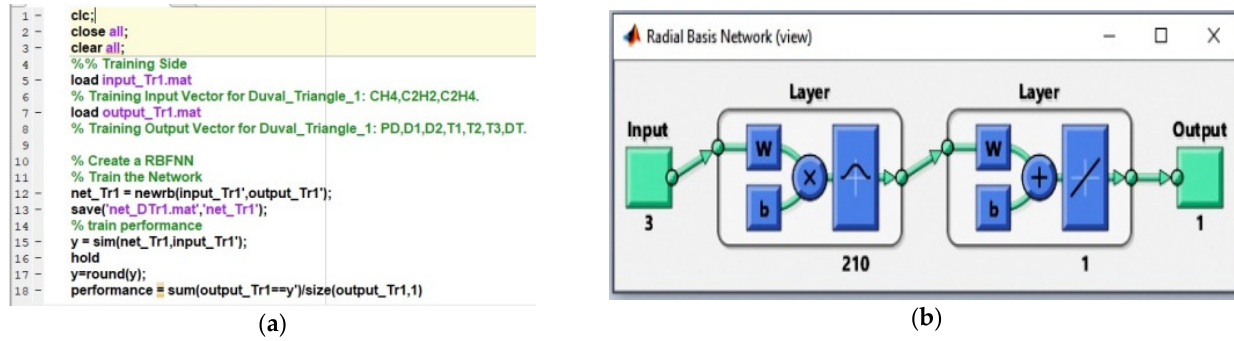
Figure 6. Example of the implementation of Duval_Triangle_1_RBFNN: ( a ) MATLAB code for creating and training the Duval_Triangle_1_RBFNN; ( b ) structure example of Duval_Triangle_1_RBFNN.